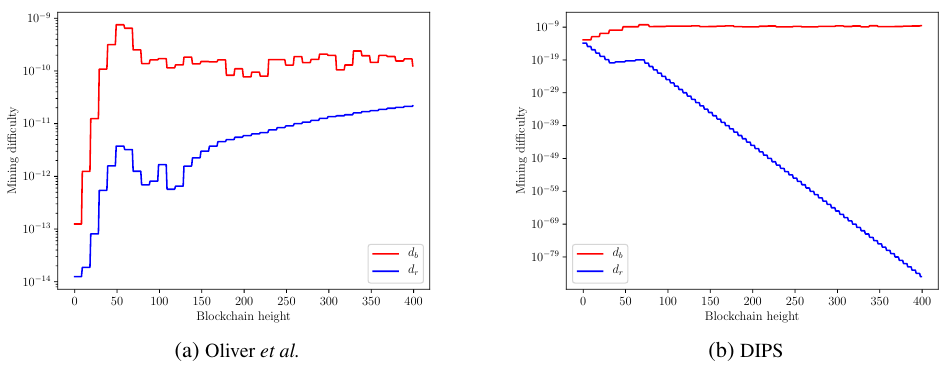
Fig. 3. Difficulties d r (blue) and d b (red) as a function of block height for a typical run of the simulation described in Section 3. For Oliver et al. we set η = 200 − 1 , and remaining parameters are kept from Figure